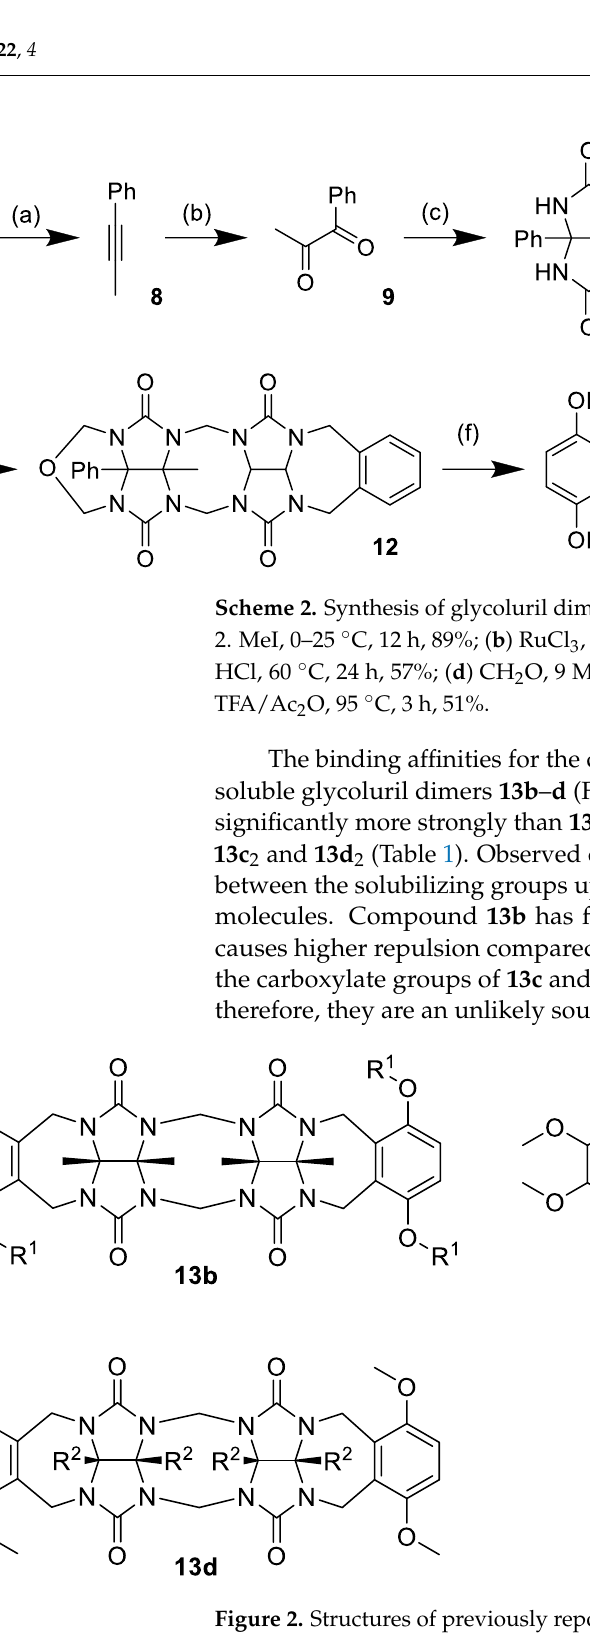
Scheme 2. Synthesis of glycoluril dimer 13a . Reaction conditions: ( a ) 1. n -BuLi, THF, −78 °C, 40 h , 2.